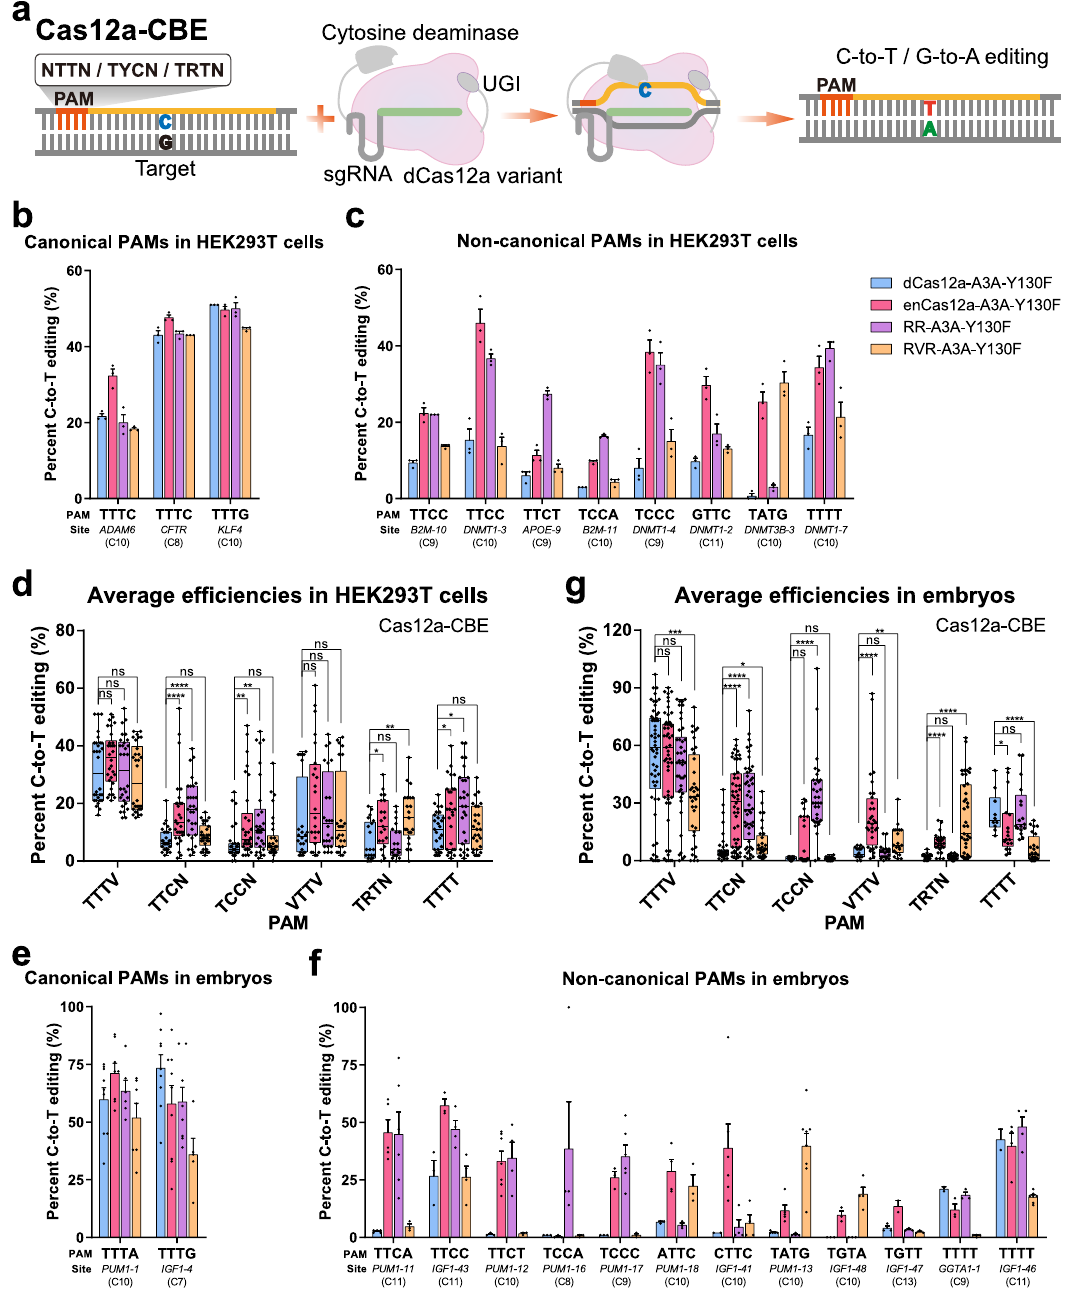
Fig. 1 Ef fi cient C-to-T conversion by Cas12a variant-mediated CBEs for non-canonical PAMs. a Schematic of C-to-T editing on targets with non-canonical PAMs by Cas12a variant-mediated CBEs. PAM protospacer-adjacent motif; UGI uracil DNA glycosylase inhibitor. Ef fi ciencies of Cas12a variant-mediated CBEs, including dCas12a-, enCas12a-, RR-, and RVR-A3A-Y130F, for canonical TTTV PAM ( b ) and non-canonical PAMs ( c ) in HKE293T cells ( n = 3). d Average ef fi ciencies of Cas12a variant-mediated CBEs at 17 sites in HEK293T cells with individual PAMs. Related to b , c , and Supplementary Fig. 5. Ef fi ciencies of Cas12a variant-mediated CBEs for canonical TTTV PAM ( n ≥ 5) ( e ) and non-canonical PAMs ( n ≥ 2) ( f ) in porcine embryos. g Average ef fi ciencies of Cas12a variant-mediated CBEs at 14 sites in porcine embryos with individual PAMs. Related to e , f , and Supplementary Fig. 6. Values and error bars for b , c , e , and f represent the mean and SEM, respectively. For d and g , the boxplots show the median, fi rst quartile, and third quartile, and whiskers represent the maximum and minimum values. Statistical signi fi cance was calculated by unpaired two-tailed Mann – Whitney test. ns (not signi fi cant), p ≥ 0.05; * p < 0.05; ** p < 0.01; *** p < 0.001; **** p < 0.0001.